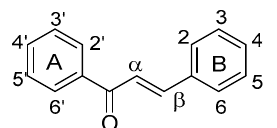
Figure 1. Basic chalcone structure.